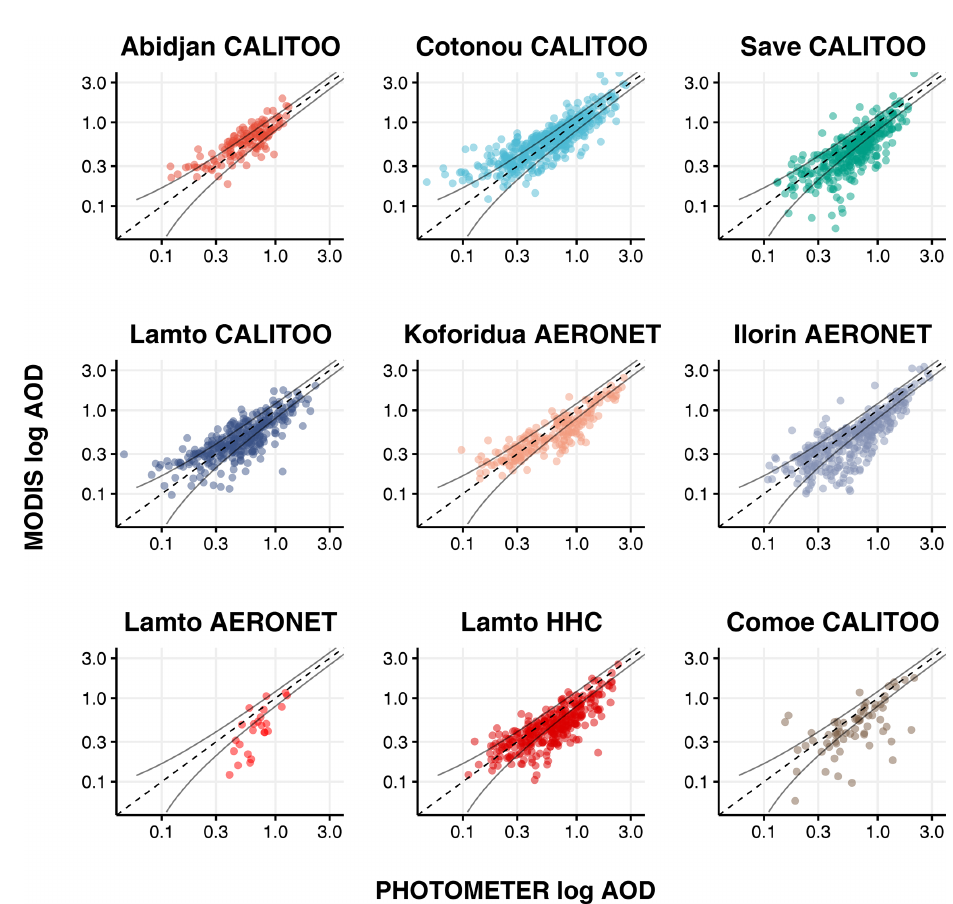
Figure 5. Scatterplots of MODIS vs. sun photometer AOD for the three types of sun photometers (automatic AERONET and handheld CALITOO and CIMEL) and different sites (Lamto, Comoé, Savè, Cotonou, Abidjan, Ilorin,